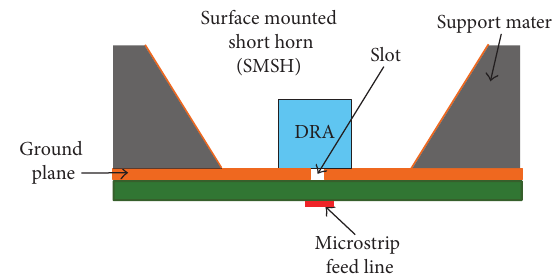
Figure 15: A surface mounted short horn (SMSH) configuration as suggested in [25].